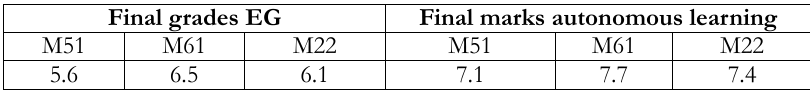
Table 3. Marks for the three groups (Final subject grades and final autonomous learning